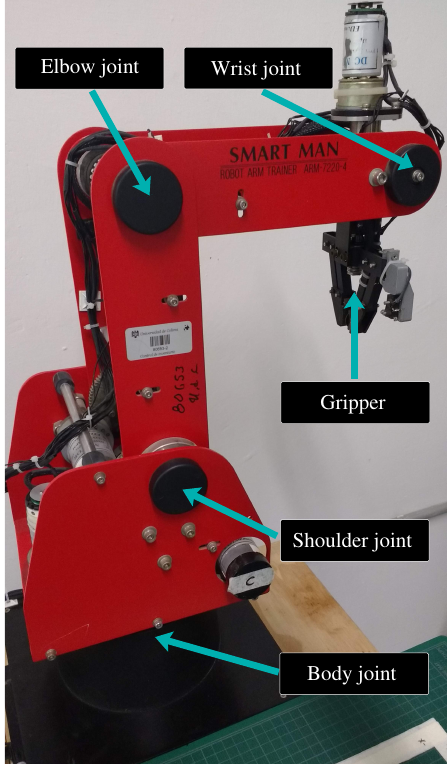
Figure 2. Recycled